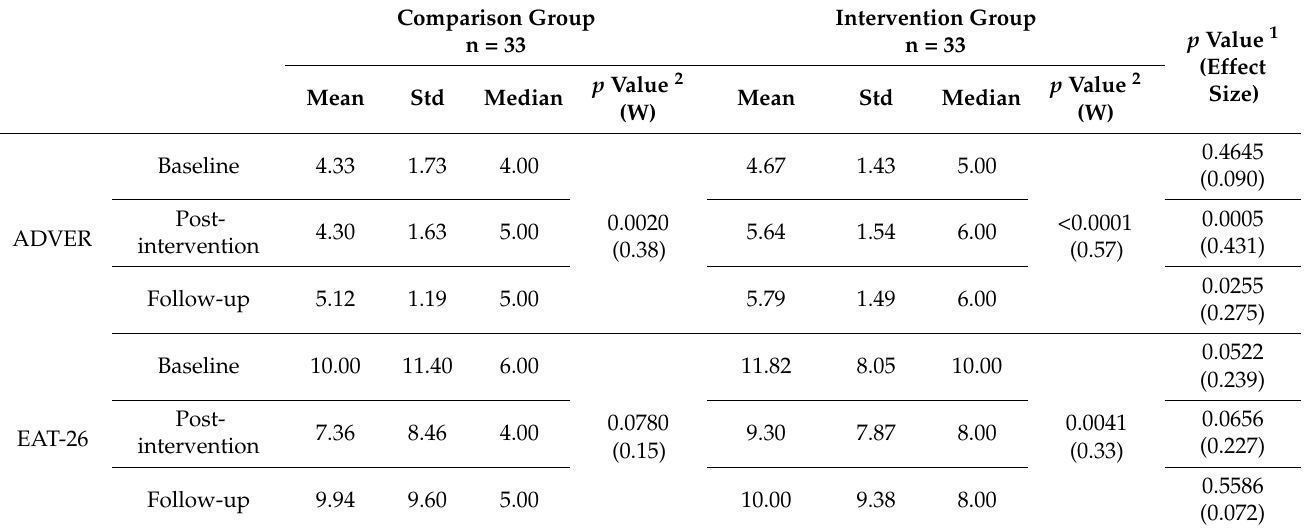
Table 6. Differences in outcome measures between groups and changes within each group (non- parametric outcome measures).